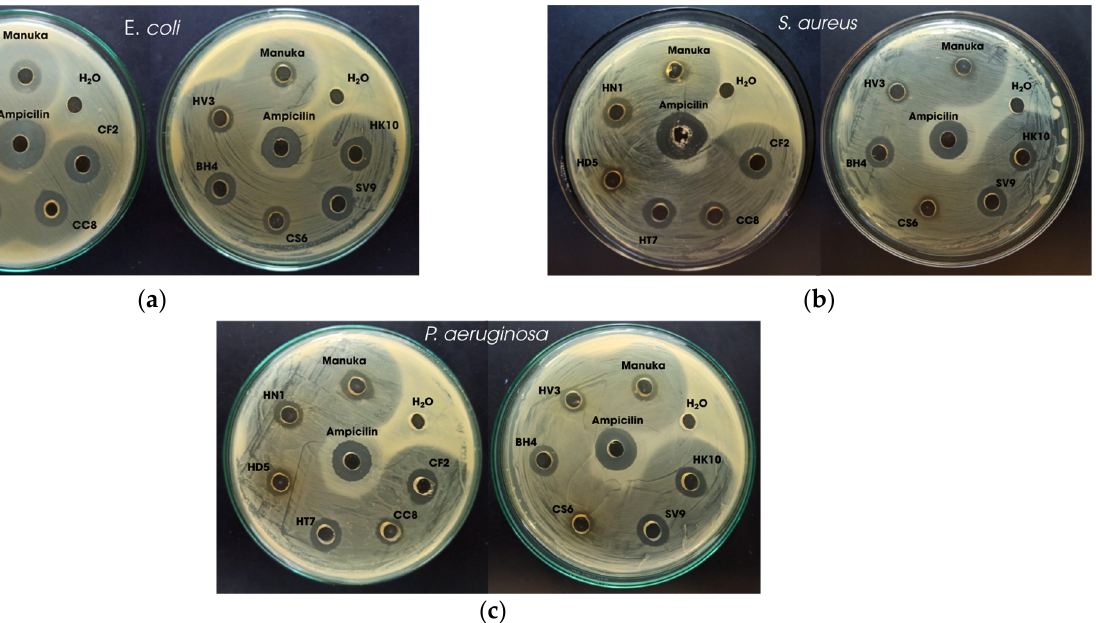
Figure 3. Antibacterial ring diameters of honeys on strains of ( a ) E. coli ; ( b ) S. aureus and ( c ) P. aeruginosa.